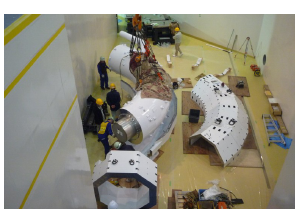
Figure 3. An installation of the transport